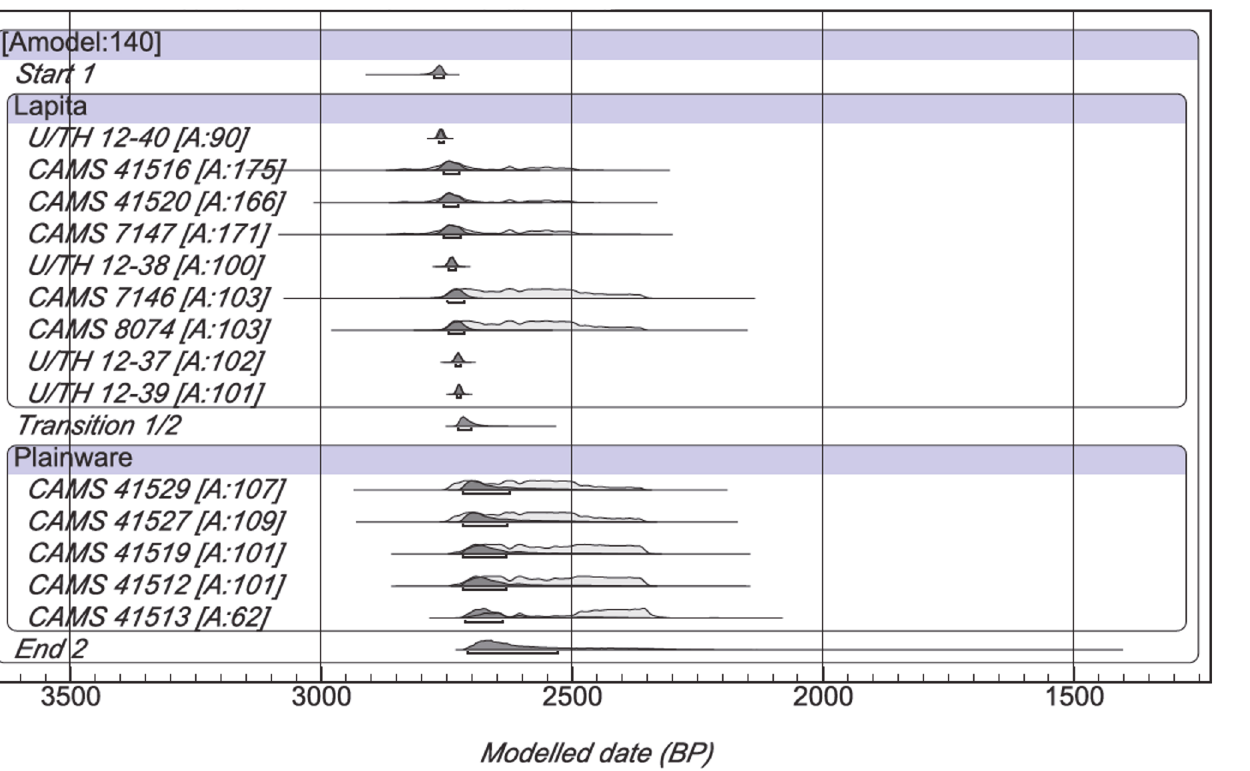
Fig 4. Bayesian contiguous model for short-lived sample and U/Th dates from Ha ʻ apai. Radiocarbon dates are calibrated at 68.2% using SHCal13 atmospheric curve [26] while the plot is a generated output of OxCal Version 4.2.3. S3 Table provides detailed data for individual dates and the